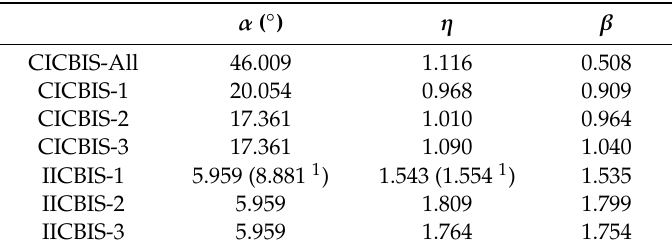
Table 3. Design parameters of the cable-bracing